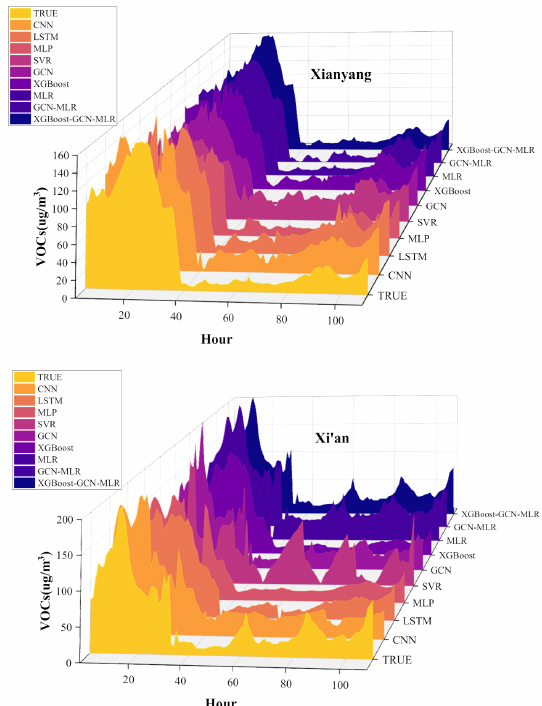
Figure 4. Fit curves of predicted and true values of nine models in five